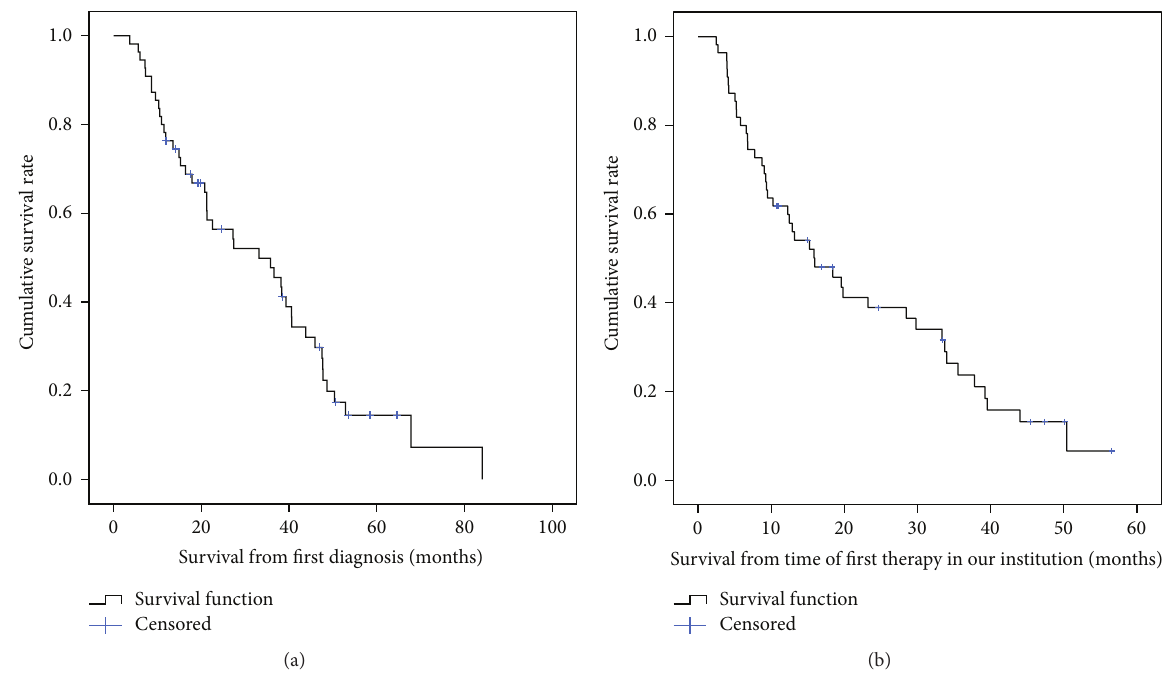
Figure 2: Overall survival rate in all patients from time of first diagnosis (a) and from time of first therapy at our institution (b). Median overall survival from time of first diagnosis: 33.1 months (95% CI 16.5–49.8 months). Median overall survival from time of first therapy at our institution: 16.0 months (95% CI 8.8–32.2